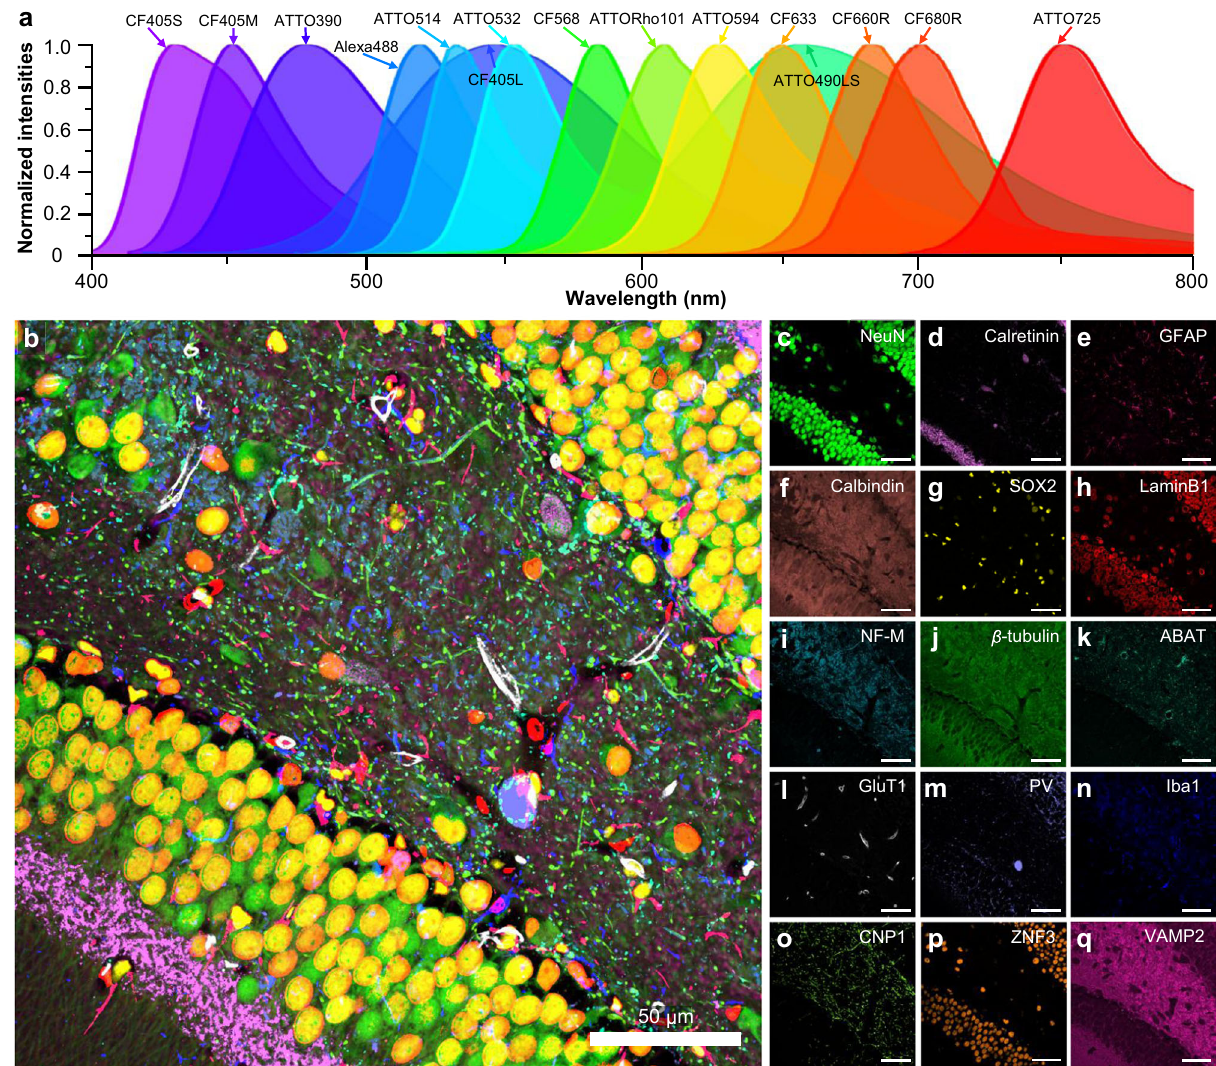
Fig. 4 Fifteen-color multiplexed imaging of the mouse brain via PICASSO. a Emission spectra of the 15 fl uorophores used. b – q Fifteen-color multiplexed imaging. Fifteen images were acquired at 15 detection channels and blindly unmixed via PICASSO. b Fifteen-color multiplexed imaging of the dentate gyrus of the mouse hippocampus. Target proteins are listed in c – q . c – q Single-channel images of b . The contrast of each channel was adjusted to clearly show all channels in b . In c – q , images were displayed without any contrast adjustments or thresholding. All scale bars; 50 μ